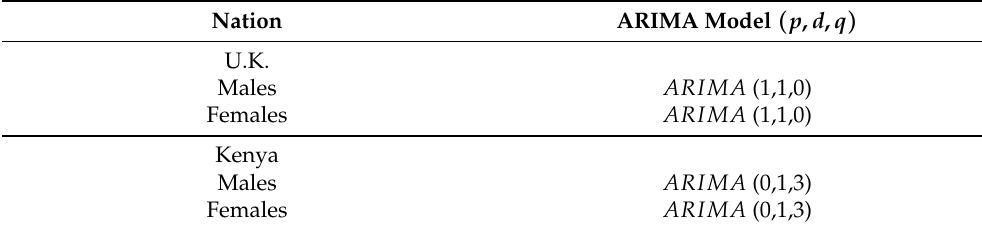
Table 3. ARIMA by Nation and